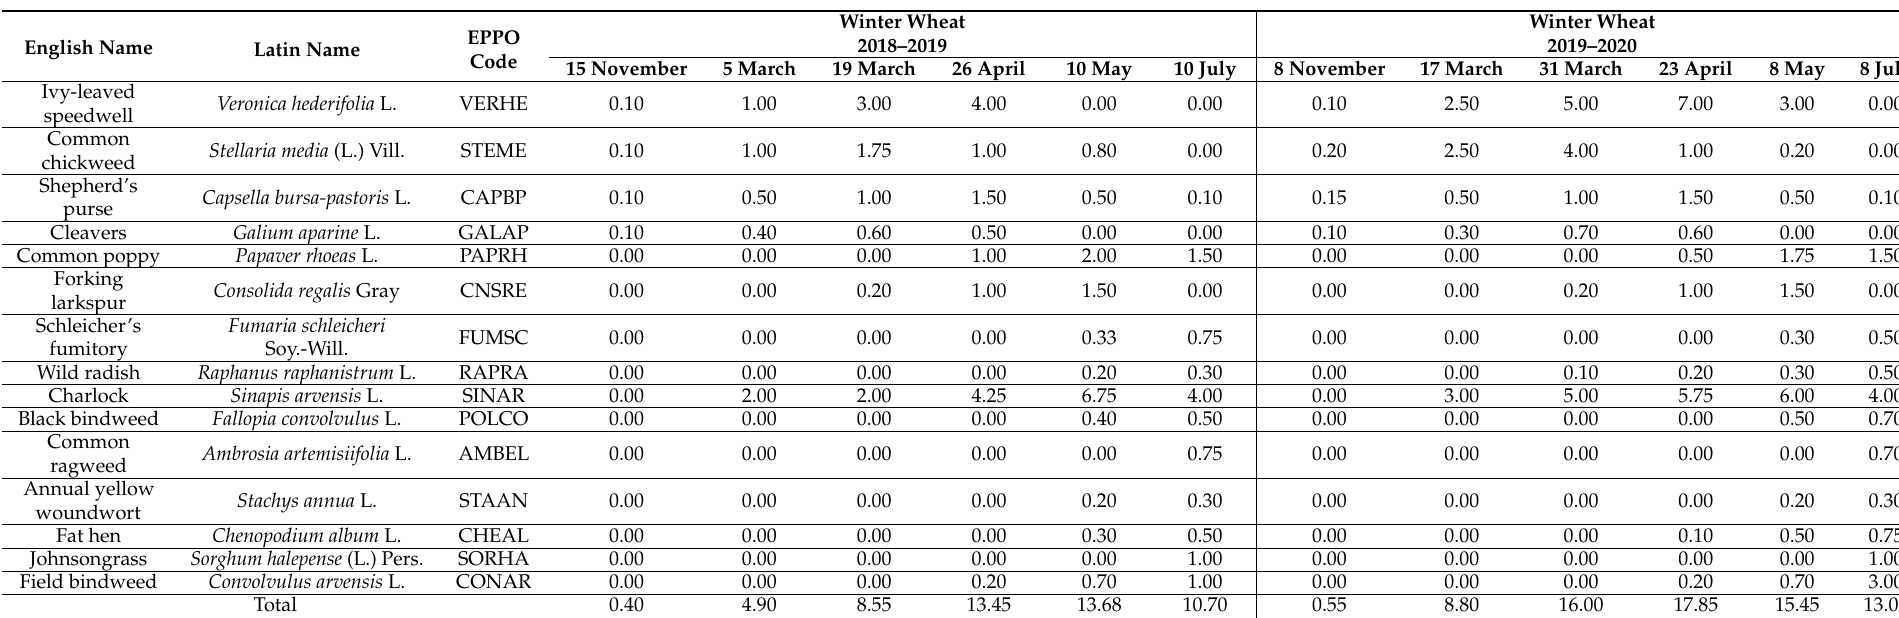
Table 4. Weed cover (%) of pure winter wheat ( Triticum aestivum L.) without weed management in control plots (2018/2019 and 2019/2020).